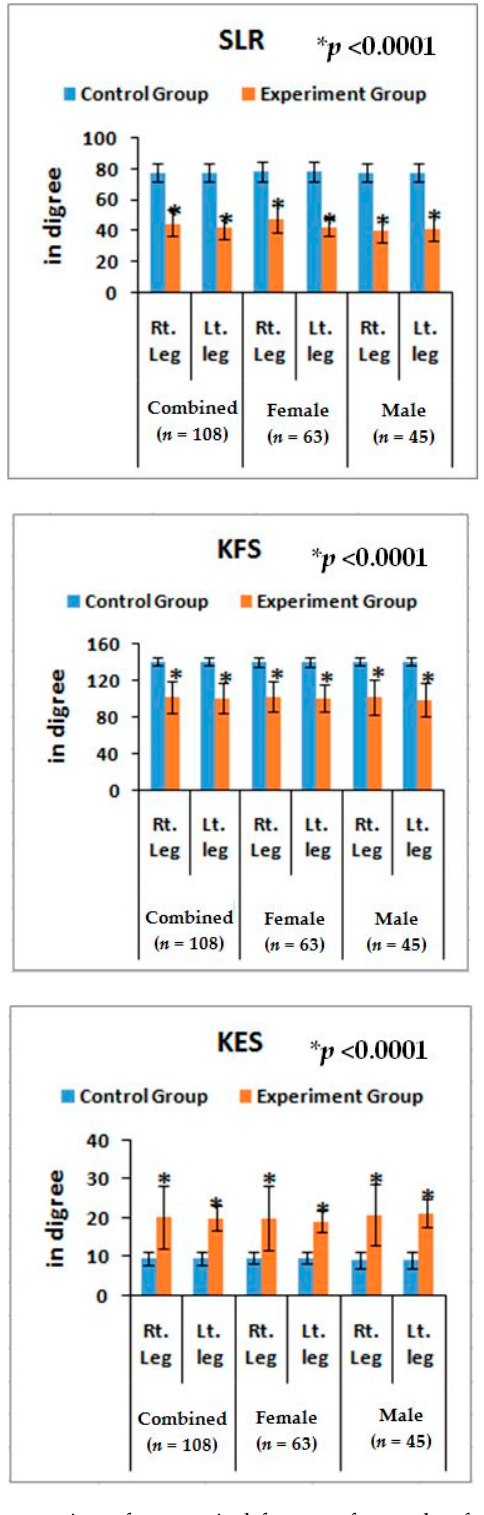
Figure 6. Graphical representation of anatomical features for angle of straight-leg raising (SLR), knee flexion in supine (KFS), and knee extension in supine (KES) in compression with control and experimental groups and their p -values.